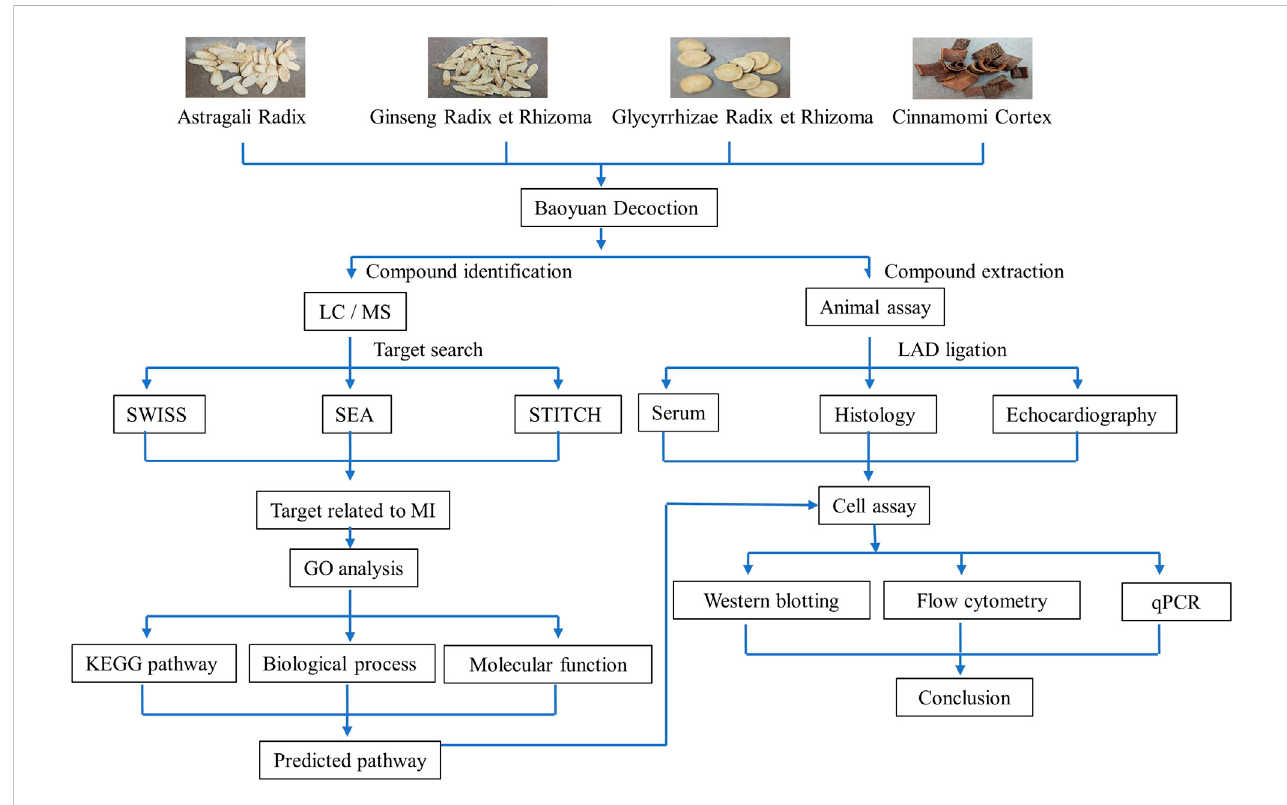
FIGURE 1 Schematic illustration of experimental